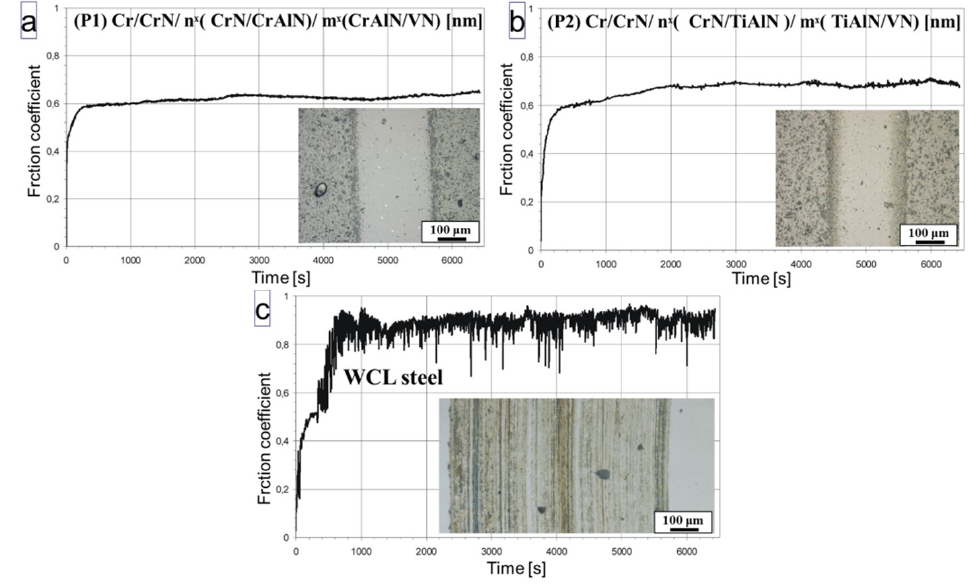
Figure 8. Wear track and friction coefficient measured for ( a ) P1, ( b ) P2 samples and ( c ) X40CrMoV5.1 tool steel.